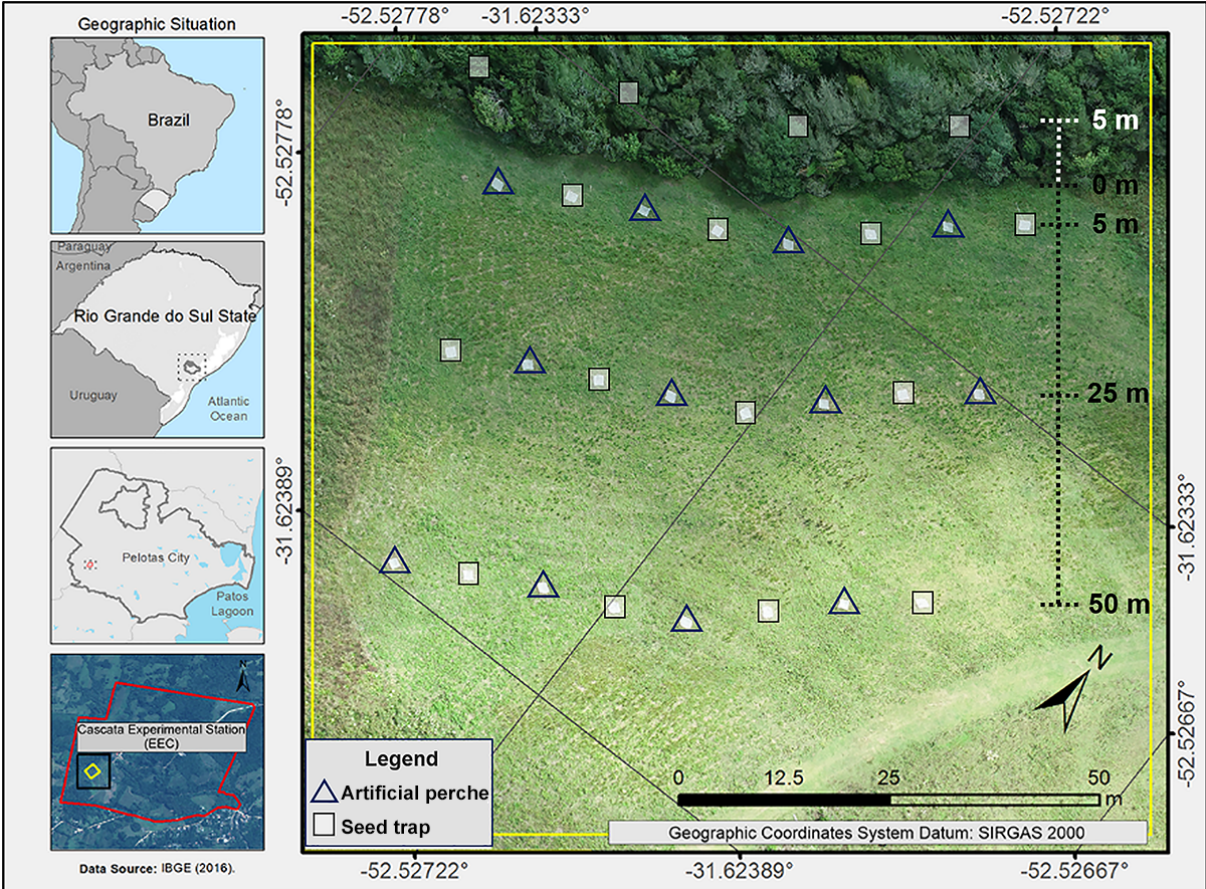
Figure 1. Experimental area of 0.4ha with artificial perches and seed traps arranged at 5, 25, and 50m from the riparian forest and 5m inside the forest fragment (elaborated by Henrique Noguez da